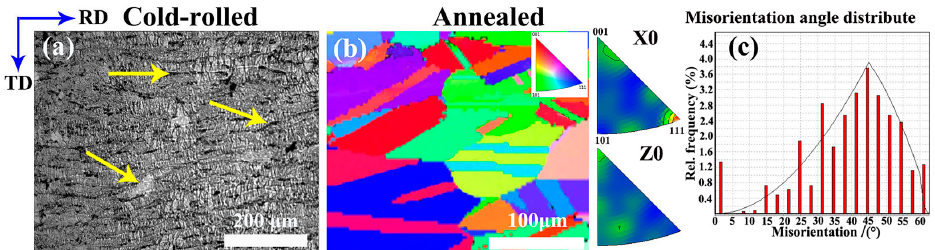
Figure 2. ( a ) OM image of the cold-rolled HEAs (with a thickness of 400 µ m); ( b ) EBSD color-coded grain orientation maps, where the colors indicate the crystal orientations parallel to the deformation direction displayed in the stereographic triangle (top right of ( b )); and ( c ) the distribution of grain boundary misorientation angles for the annealed HEAs.